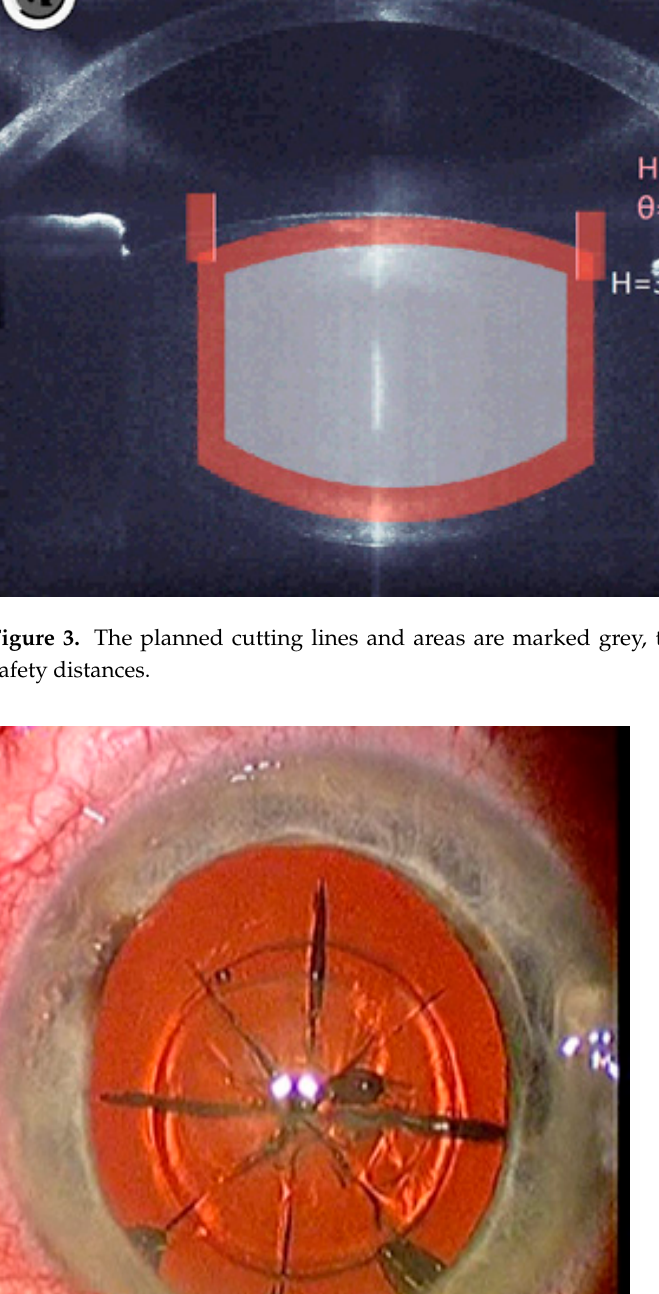
Figure 4. Status after femtosecond laser application with eight pie pieces lens fragmentation.